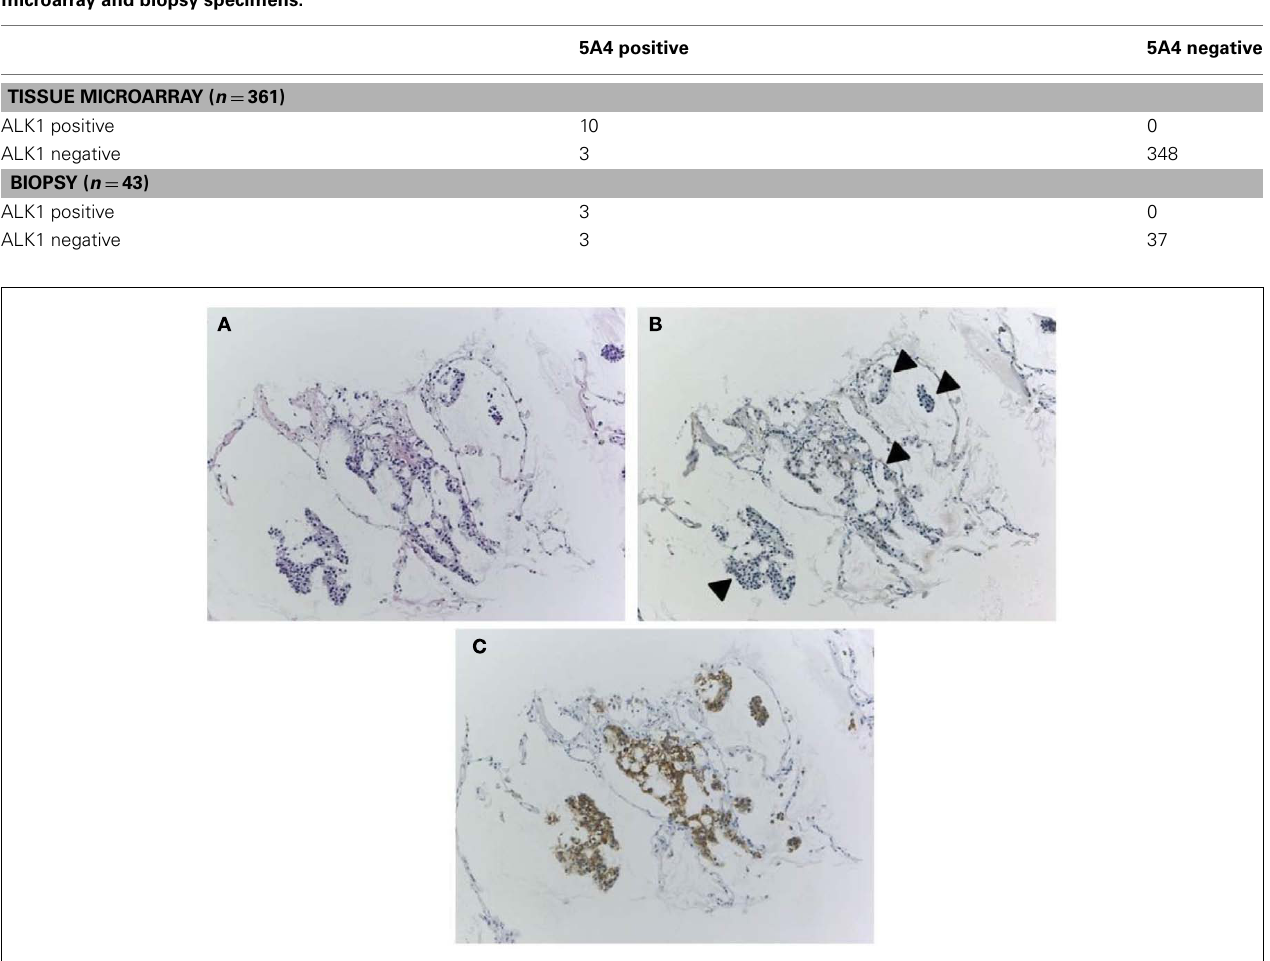
Table 4 | Comparison between conventional (ALK1 and standardABC methods) and optimized IHCs (5A4 and Flex + system) using tissue microarray and biopsy specimens.